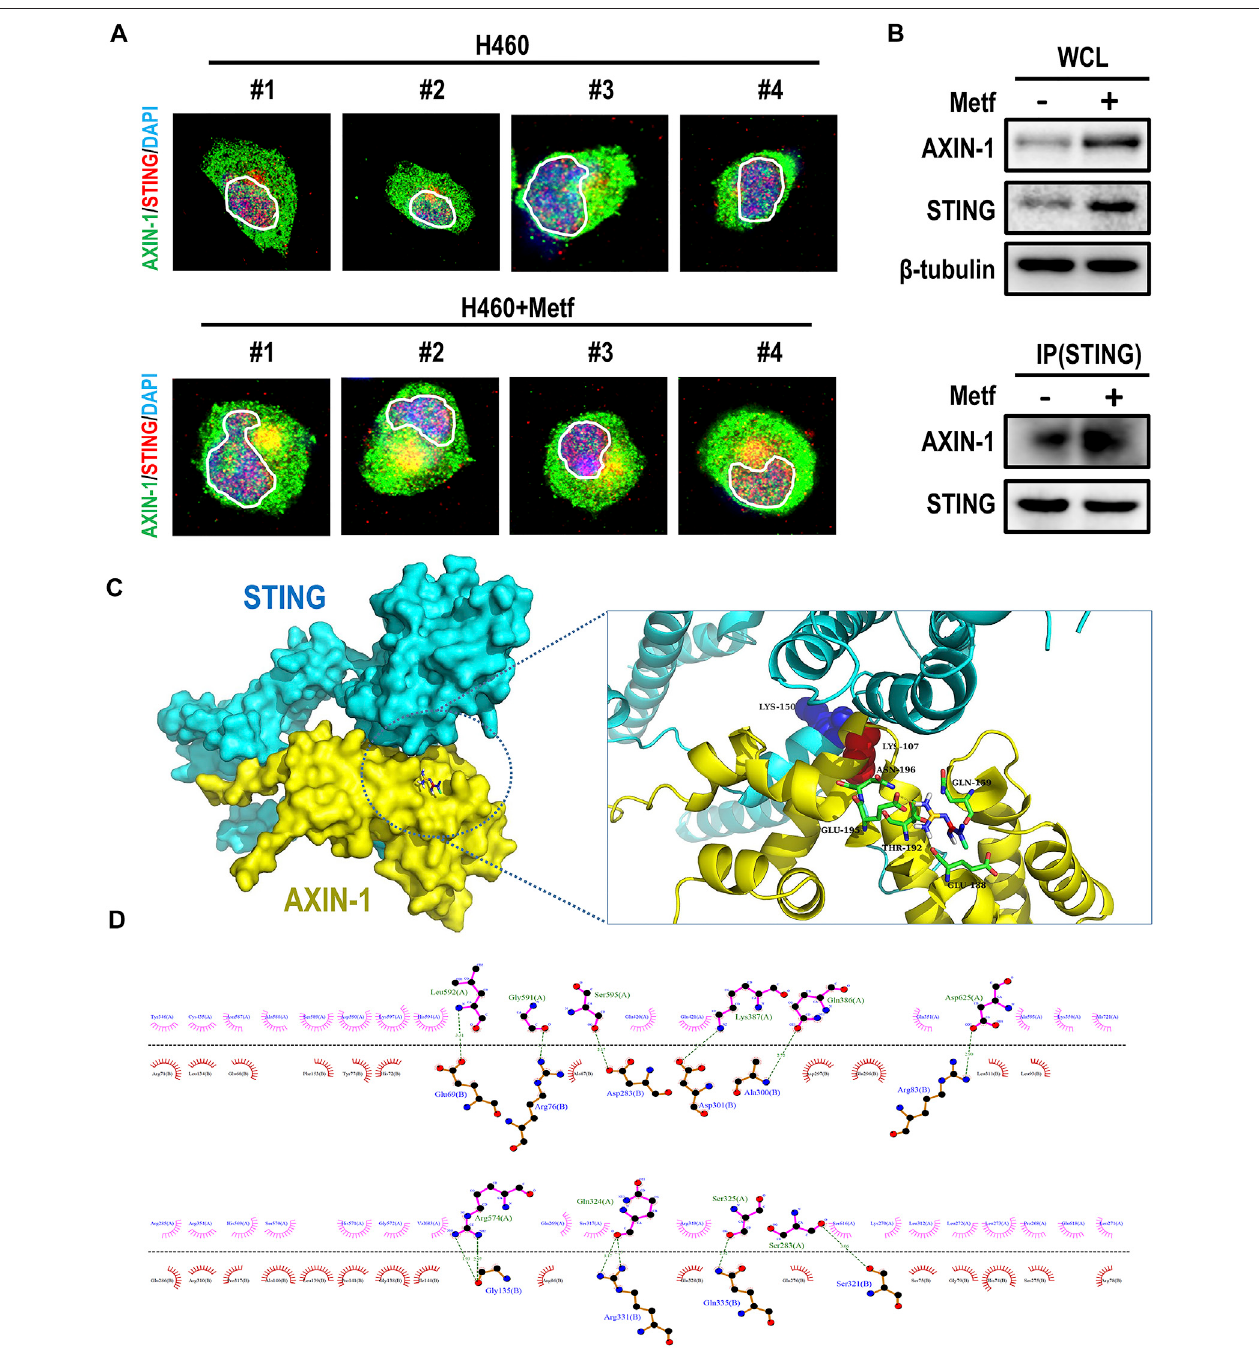
FIGURE 5 | Metformin enhanced the co-localization and binding of AXIN-1 and STING. (A) , Representative immuno fl uorescence imagesfor AXIN-1 and STING of H460 cells following metformin treatment. Yellow signals indicated co-localization. (B) , Cell lysates from H460 cells with metformin treatment were immunoprecipitated with an anti-STING antibody and then immunoblotted with anti-AXIN-1 antibody. (C) , Protein-protein docking prediction between AXIN-1 and STING. (D) , The 2D visualizationand interactionsbetweenAXIN-1and STING. Thehydrogen bondsand thehydrophobicinteractionswereshown in green-dashed lines andred arcs,